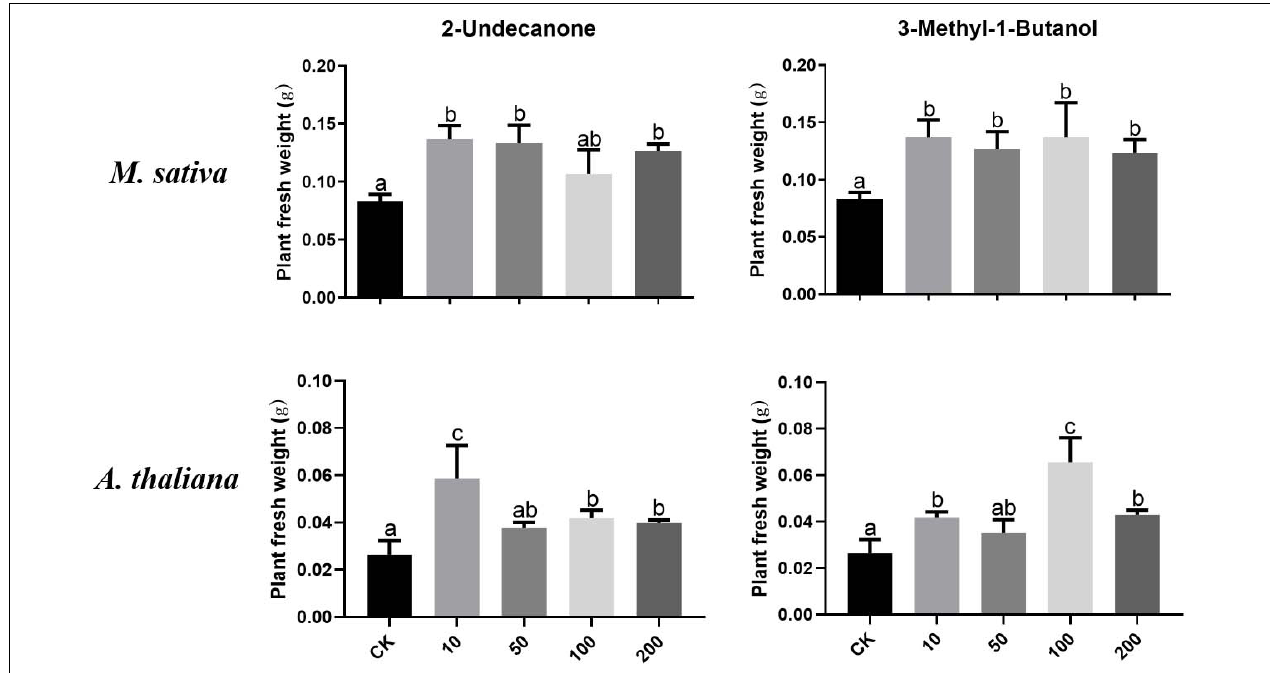
FIGURE 7 | Effects of pure compounds at different concentrations on the growth of M. sativa and A. thaliana under iron deficiency. CK: control. One-way ANOVA was performed, and Duncan’s post hoc test was applied. Different letters indicate statistically significant differences ( p < 0.05) among